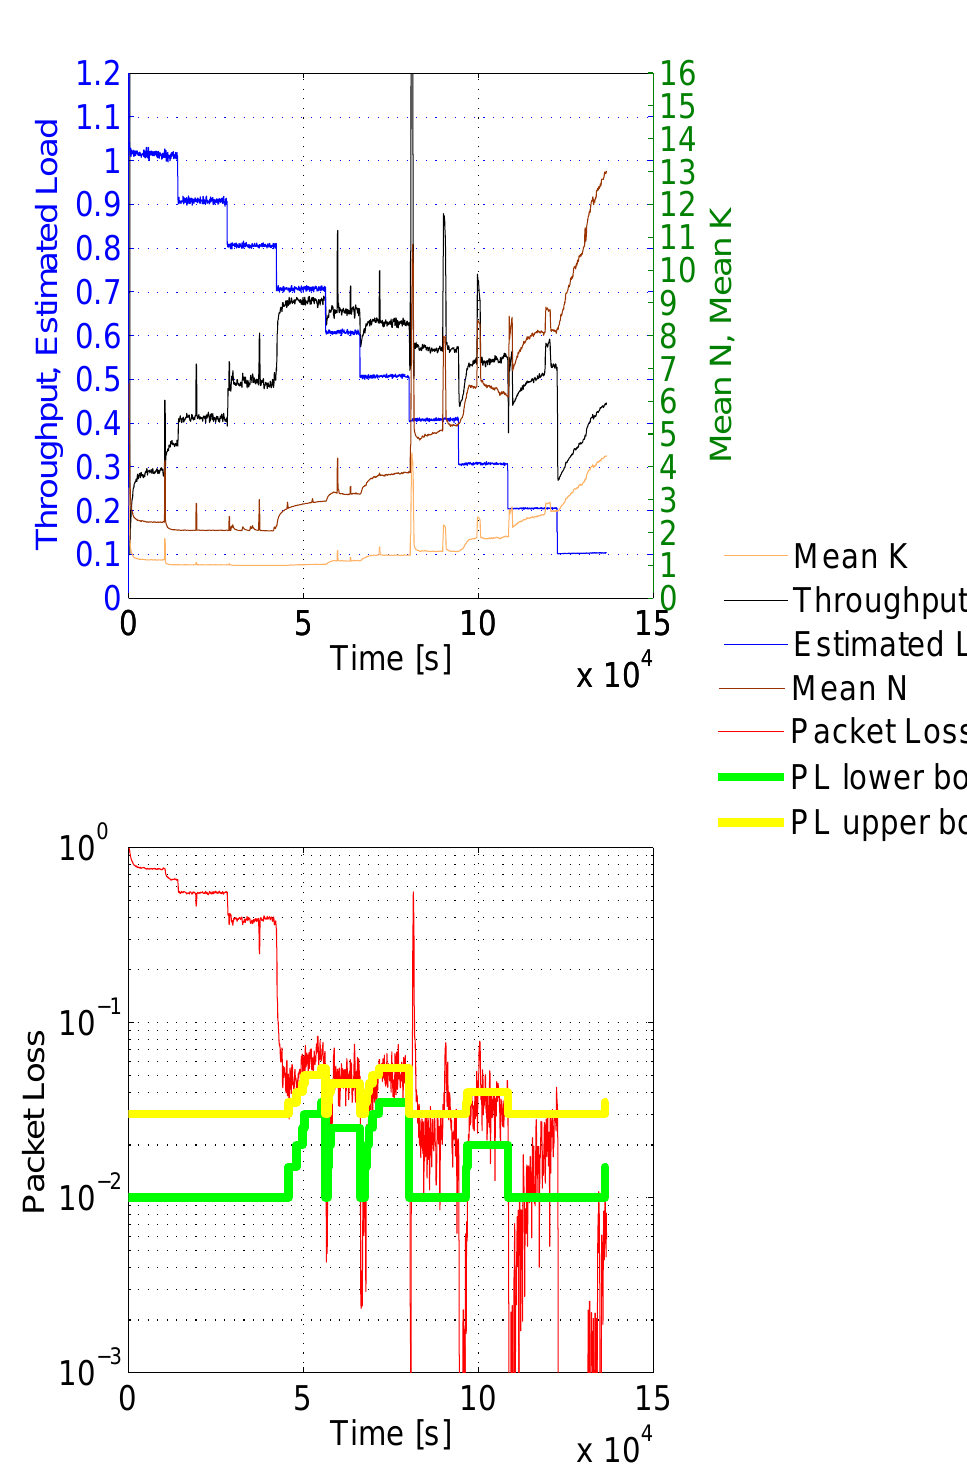
Figure 7. Throughput and Packet Loss for LC algorithm, linear code set C as in table ??